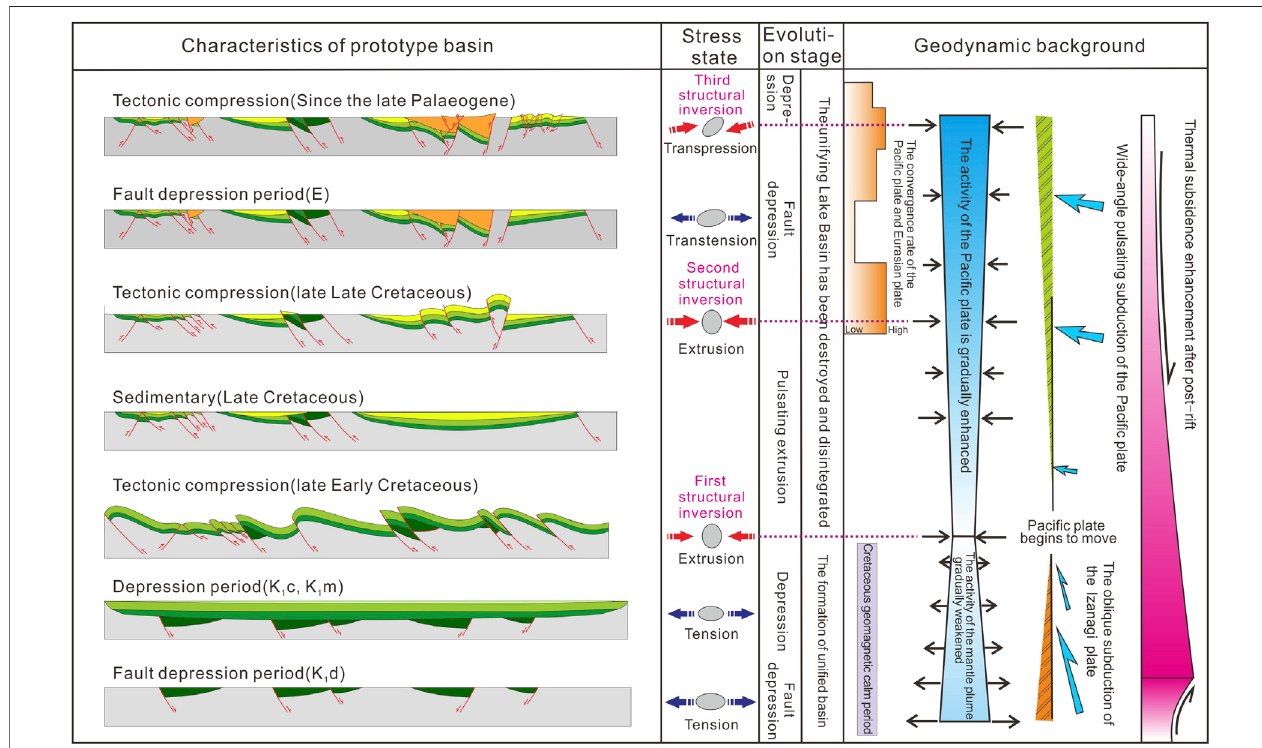
FIGURE 10 | Destruction and disintegration process and dynamic mechanism of the Dasanjiang uni fi ed basin. The gray ellipse indicates the stress state, the dark blue arrow indicates the extension state, and the red arrow indicates the extrusion state. The orange box color from light to dark indicates the convergence rate of the Paci fi c-Eurasian platefrom lowtohigh, thebluebox colorfromlighttodarkindicates theactivity ofthemantleplumeandthePaci fi cplateisgraduallyincreasing,andthe angle and size of the light blue arrow indicate the subduction rate and angle of the Izanagi plate and the Paci fi c plate, and the pink box color from light to dark indicates the thermal subsidence enhancement after